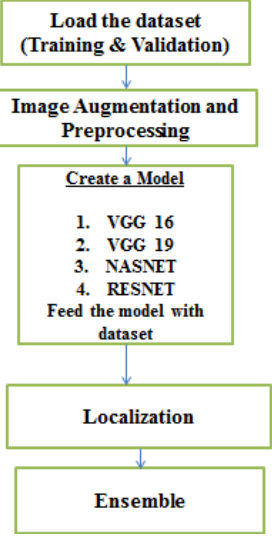
Figure 9. CNN Models used in Proposed